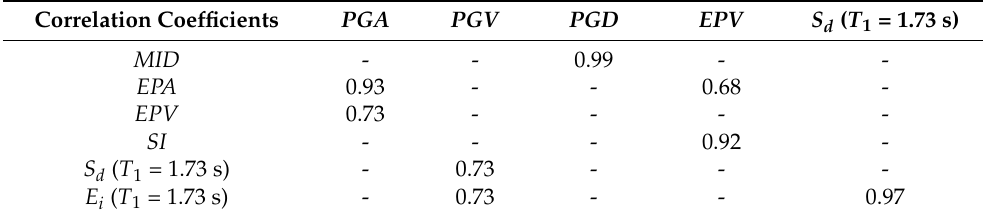
Table 9. Correlation coefficients for related parameters ( p < 0.05).